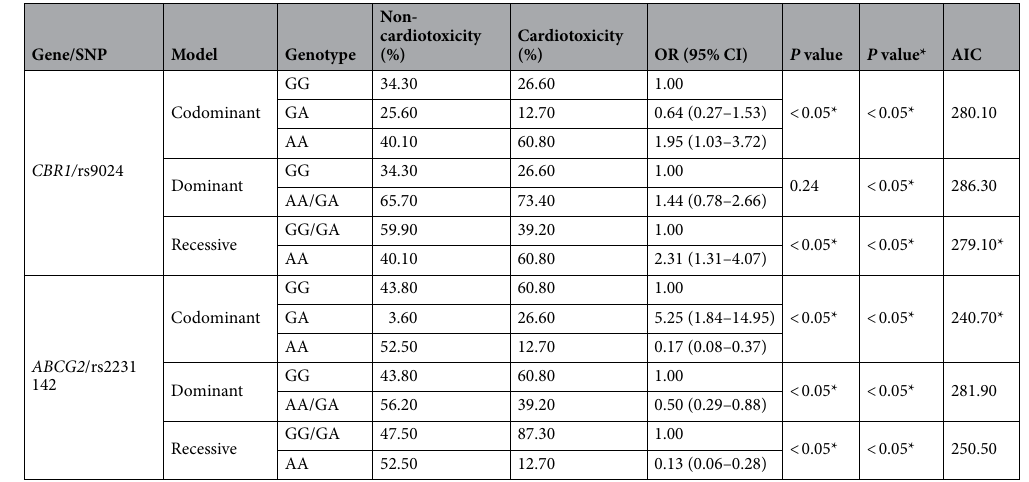
Table 2. Genetic contrast model for cardiotoxicity in ALL patients (* shows significant values). P value* (Bonferroni corrected) < 0.05 was considered